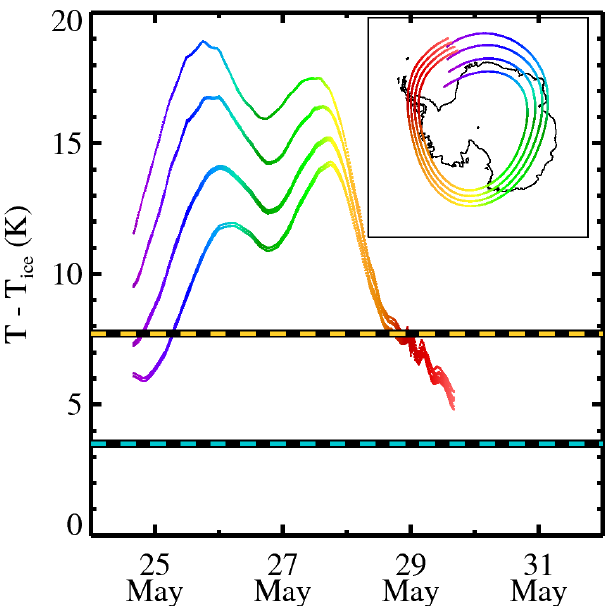
Fig. 19. As Fig. 18 but for a MIX2 PSC detected along orbit track 9 on 29 May 2008 (see Figs. 12b and